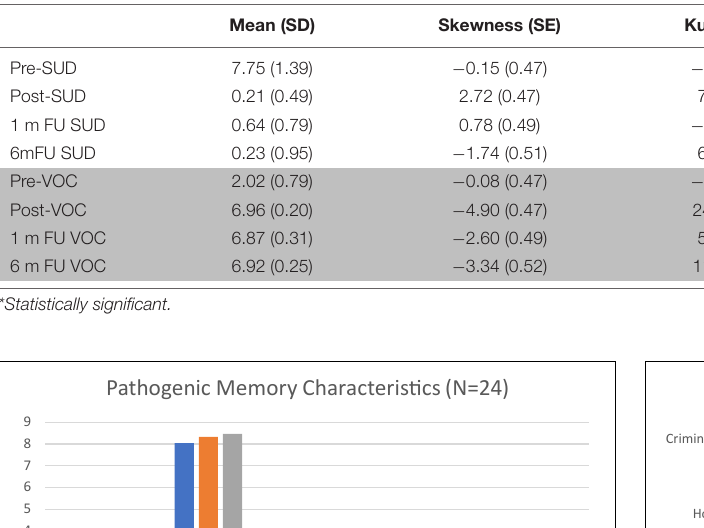
TABLE 5 | Means, SD, skewness, and kurtosis for SUD and VOC at pre, post, 1-month, and 6-month FUs.